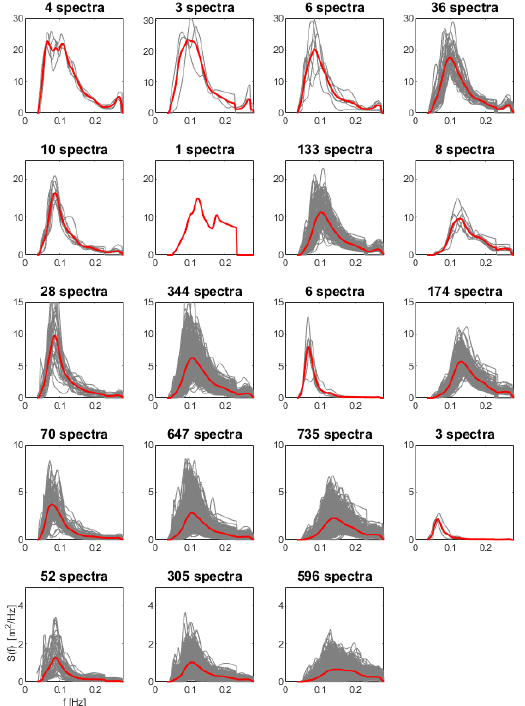
Fig. 5. Each group’s wave spectra and their representative sea states in S(f) space, title represents the number of each group’s members for method A.